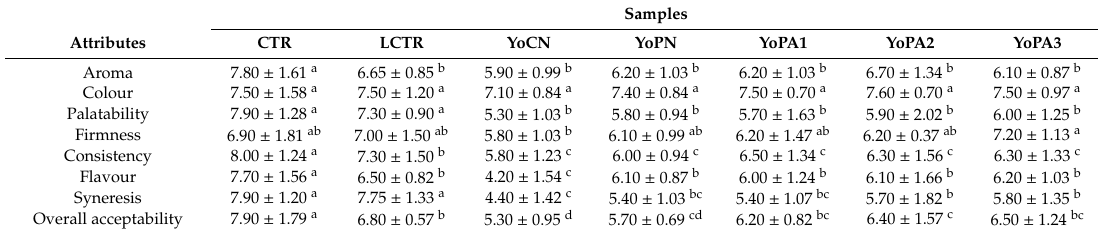
Table 4. Sensory attributes of yoghurt stabilized with acetylated pigeon pea